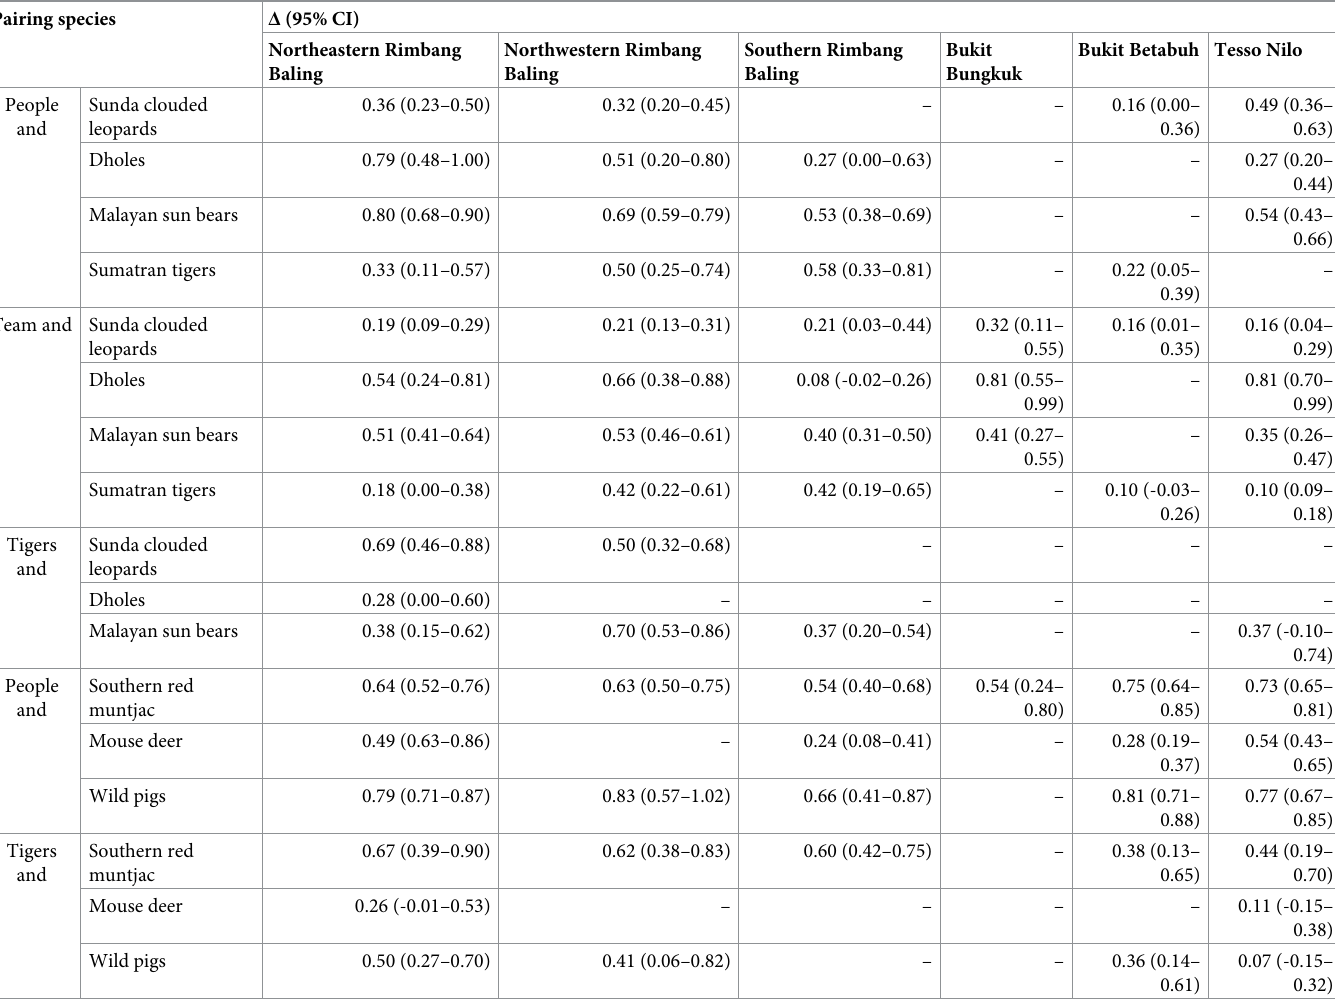
Table 2. Estimates of temporal overlap ( Δ ) with 95% bootstrap confidence interval of people, team, large carnivores, and potential prey species for all study sites. Pairing